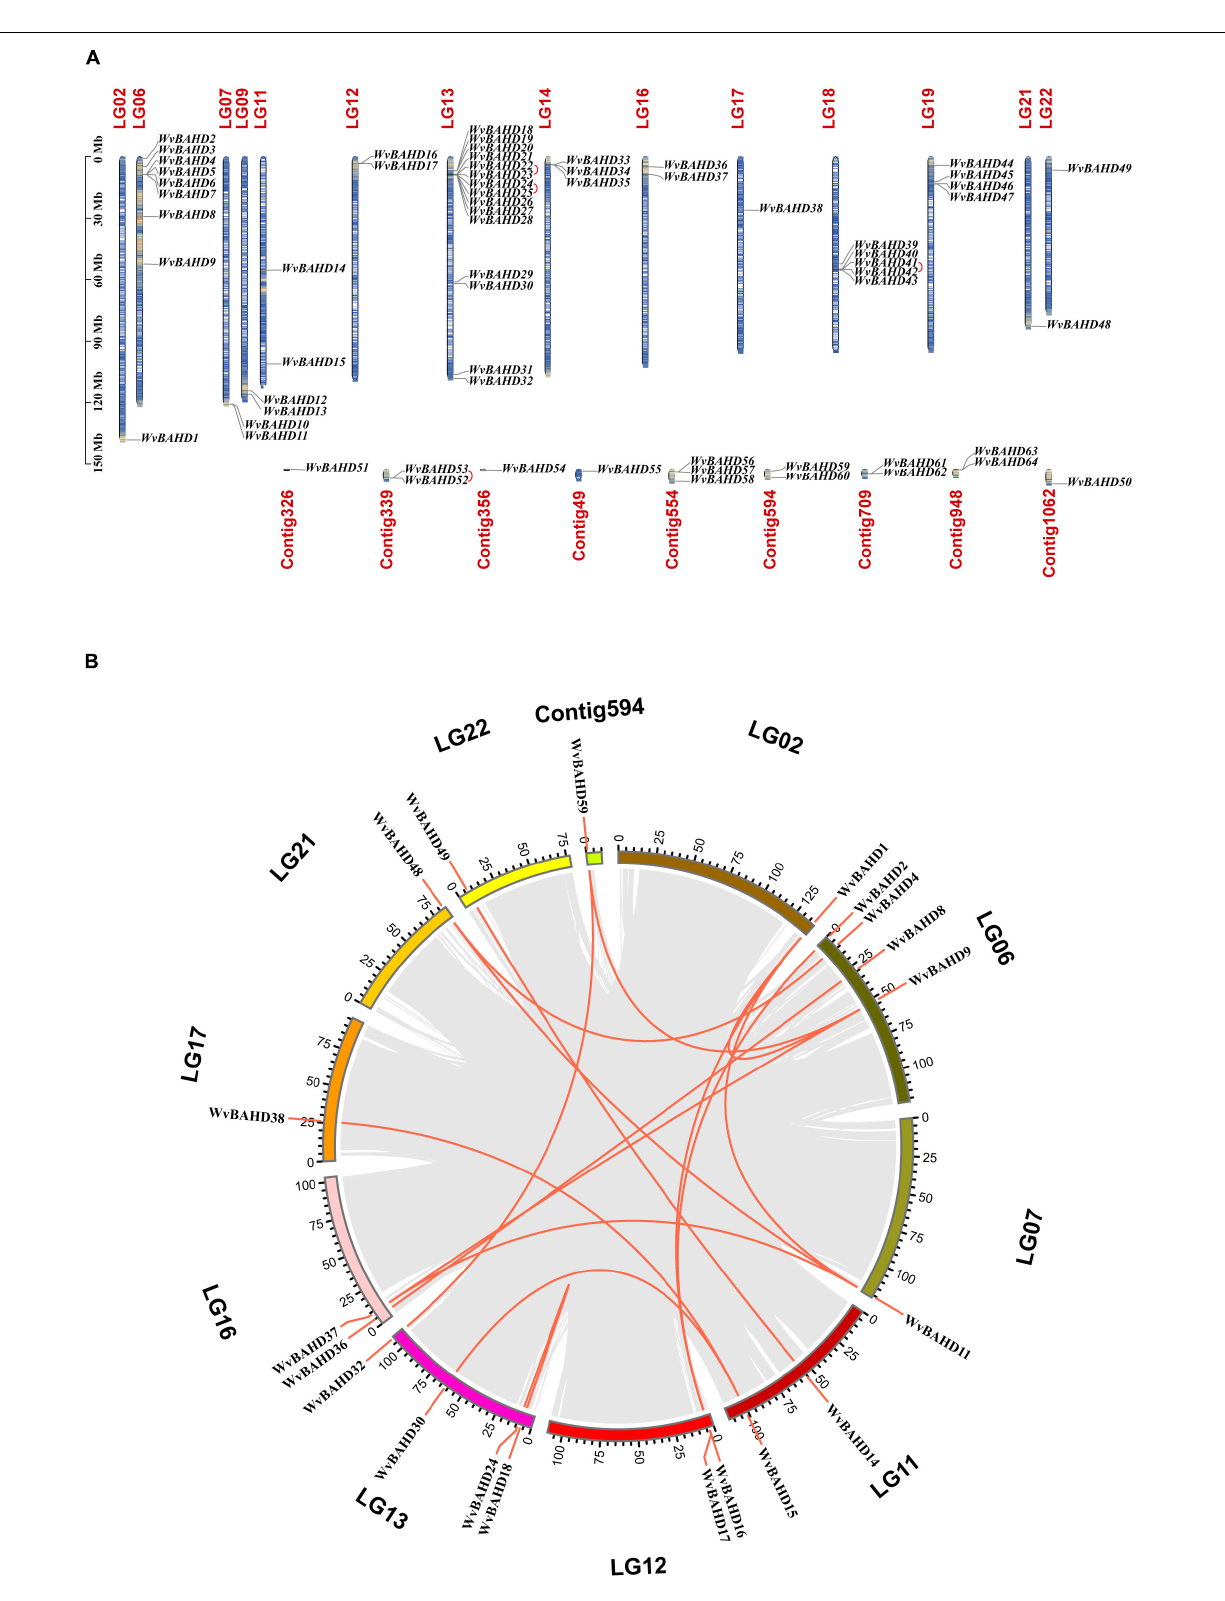
Frontiers in Plant Science |